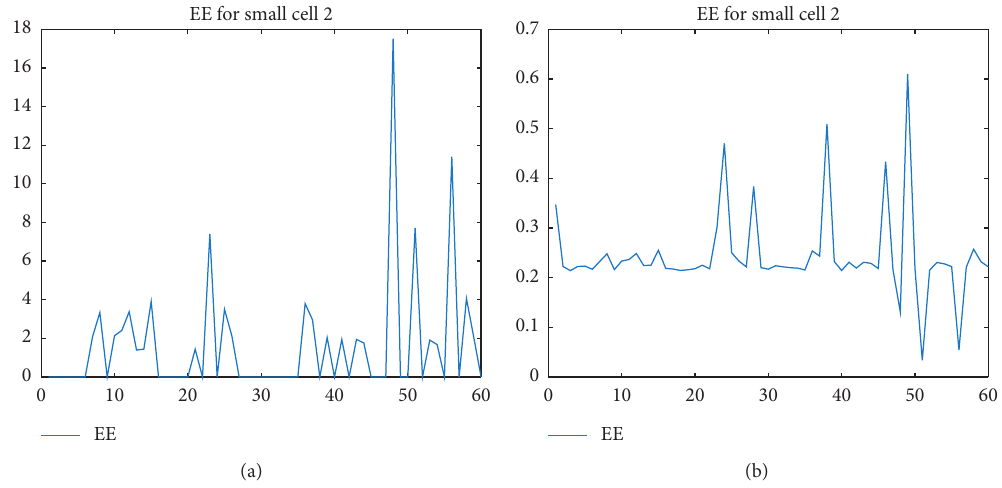
Figure 7: The energy efficiency (a) and SINR (b) of small BS 2 for 60 MUE.